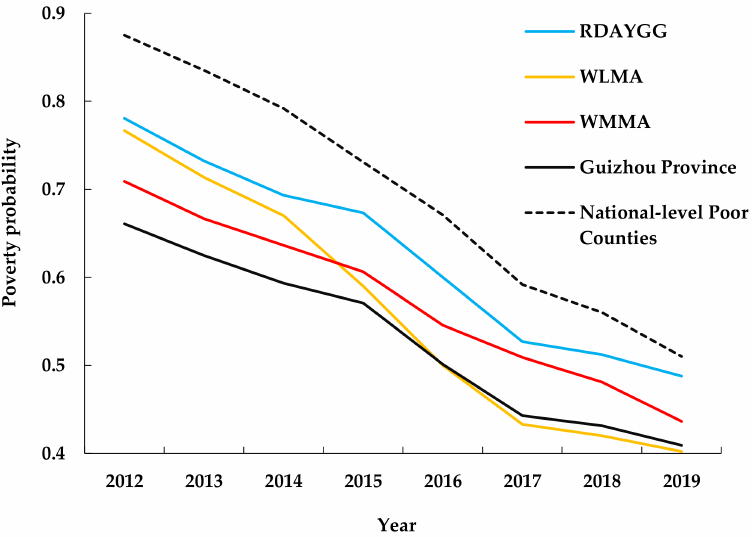
Figure 13. Average poverty probability from 2012 to 2019 at different spatial